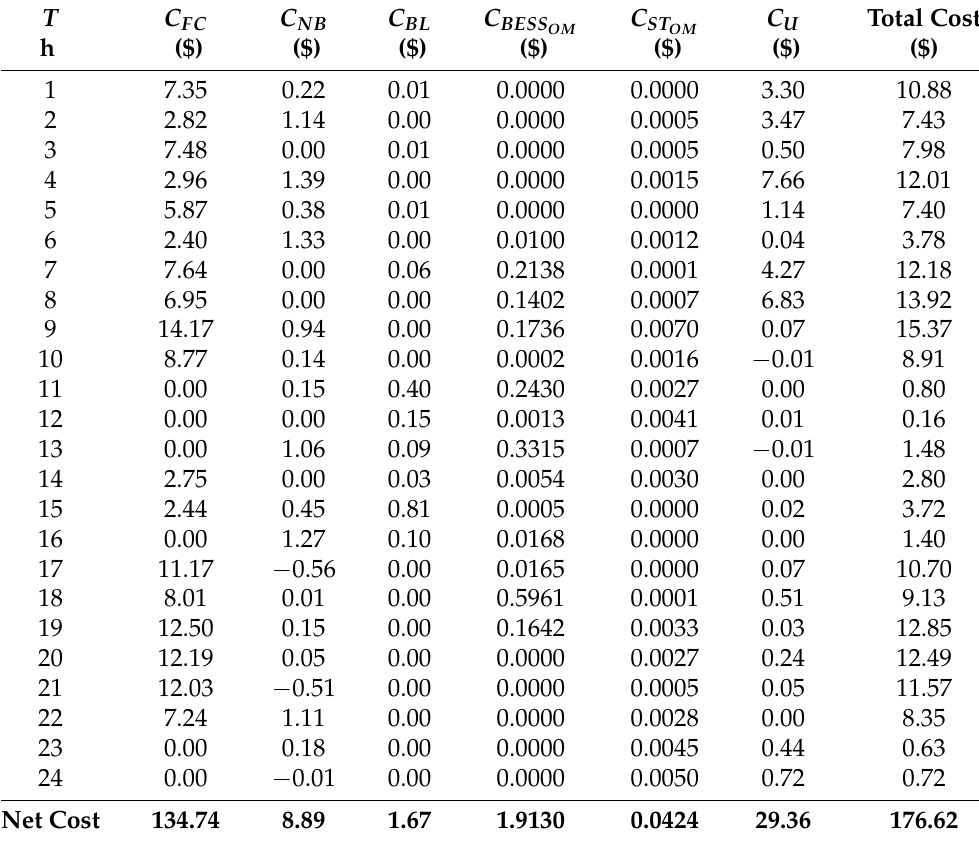
Table 7. 24 h cost of the smart